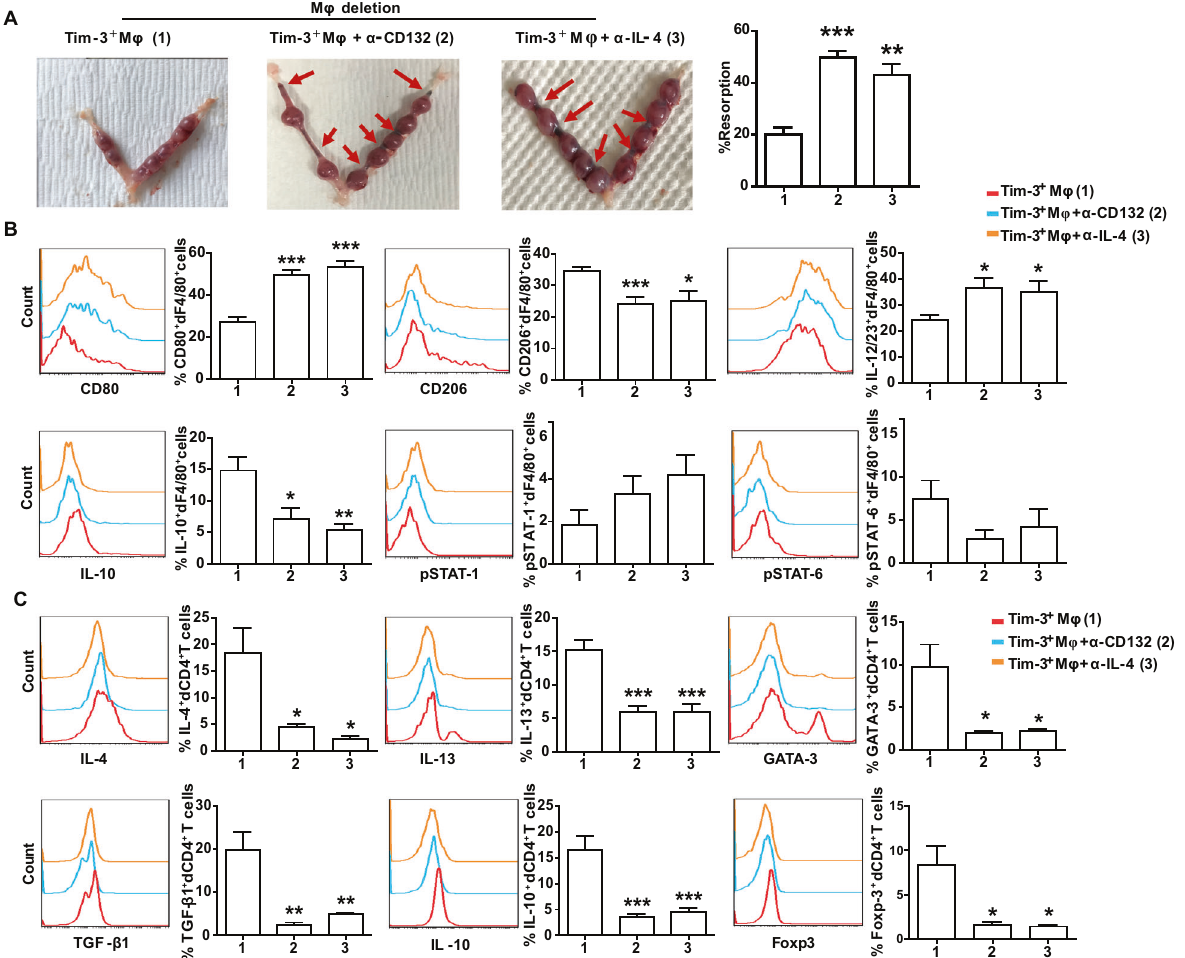
Fig. 6 Blockade of CD132 pathway counteracted protective effect of Tim-3 + M φ s on murine pregnancy. A Representative images of uterus and the percent of fetal resorption in pregnant CBA/J mice with M φ depletion that received adoptive transfer of indicated Tim-3 + M φ s. Fetal loss sites could be identi fi ed as hemorrhagic spots and necrosis (red arrows). B Flow cytometric analysis and quanti fi cation of frequency of surface molecule, cytokine and transcription factor expression by dF4/80 + cells from pregnant CBA/J females with M φ depletion that received adoptive transfer of indicated Tim-3 + M φ s. C Quanti fi cation of fl ow cytometric analysis of cytokine production and transcription factor expression by dCD4 + T cells from pregnant CBA/J females with M φ depletion that received adoptive transfer of indicated Tim-3 + M φ s. Data represent the mean ± SEM of n = 4 – 9 mice per group and are representative of three independent analyses. * p < 0.05, ** p < 0.01, *** p < 0.001, compared with the Tim-3 + M φ s